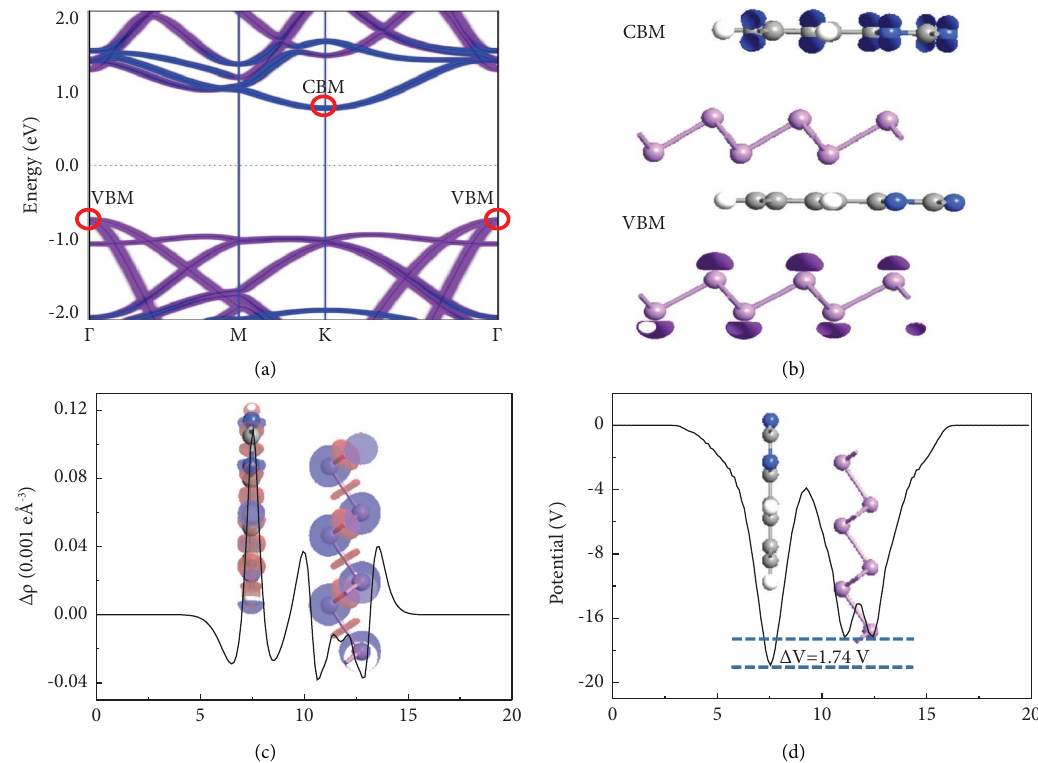
Figure 4: (a) Projected band structure and (b) charge-density iso-surfaces of CBM and VBM states of CTF/As vdWhs. Te blue and purple electronic states denote the contribution from the CTF and As layer, respectively. (c) Plane-averaged charge density diference and (d) electrostatic potential energy of CTF/As vdWhs along z -direction normal to the heterostructure. Te inset in (c) is the 3D isosurface of the charge density diference.